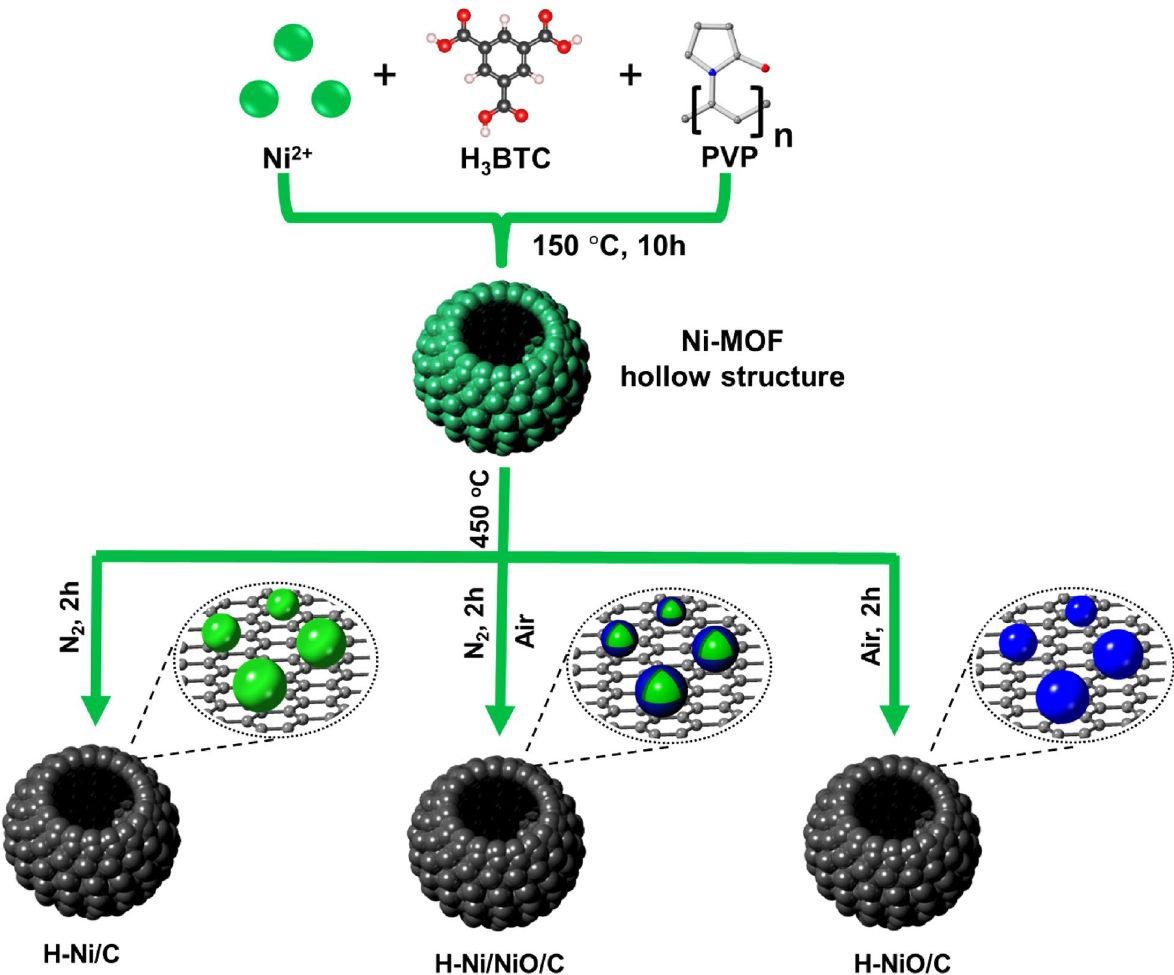
Fig. 1 Schematic illustrating the fabrication of H–Ni/C, H–Ni/NiO/C, and H–NiO/C